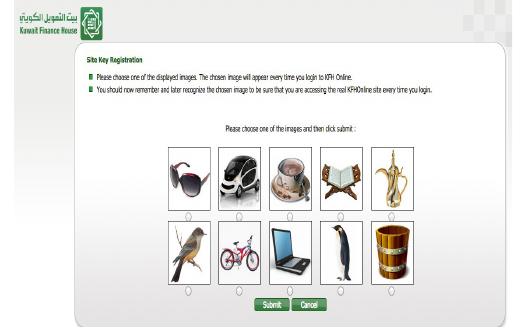
Figure 1-2: Picture and Description.